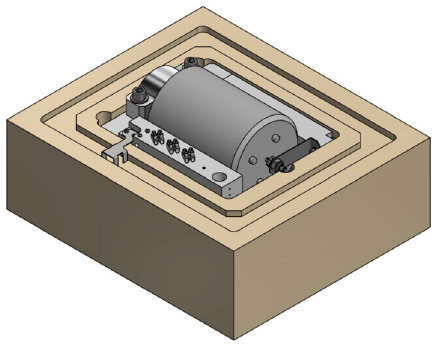
Figure 7. View of the transmission holder in the thermal casing.